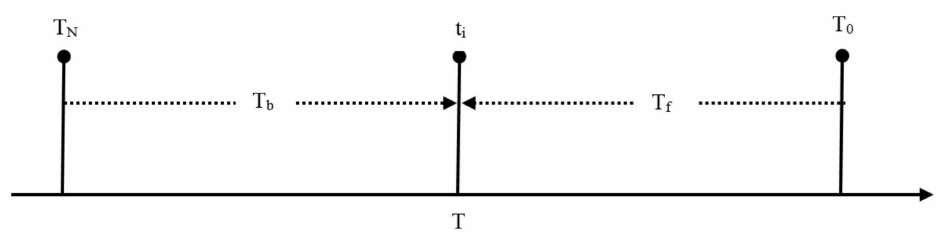
Figure 2. Schematic diagram for seismicity changes identification. A time segment T of the earthquake catalogue is divided in sub-intervals with supposedly di ff erent seismicity properties: e.g., T b is background seismicity, T f is a cluster, e.g., foreshock sequence, prior the mainshock origin time, T 0 . Suppose T f is characterized by significant seismicity changes with respect to T b . To identify seismicity changes, a long number of T b / T f pairs are examined by shifting time t i forwards or backwards. In practice, the time lengths of T b and T f are changed by removing one time unit (e.g., 1 day) or a certain number of events from T b and adding to T f inversely. The start and end times of the changes are determined from the maximum significance levels found among all possible pairs (Section